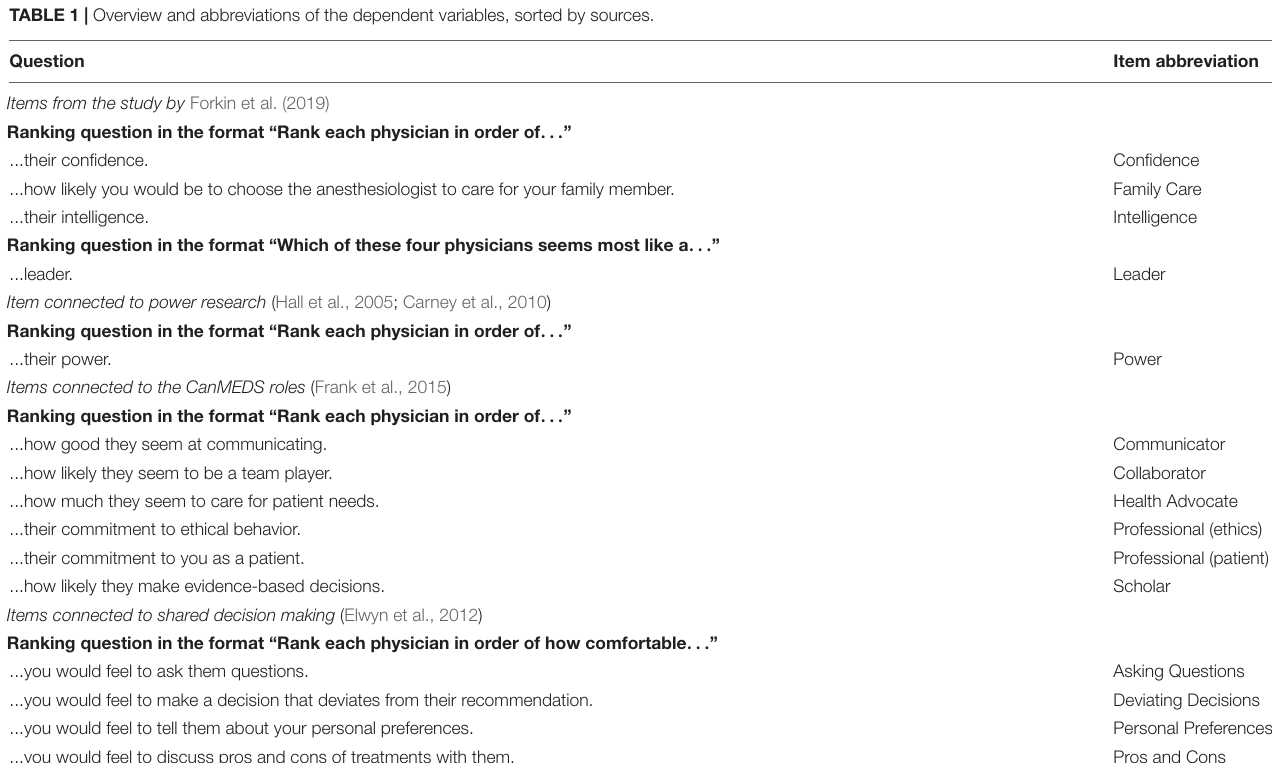
TABLE 1 | Overview and abbreviations of the dependent variables, sorted by